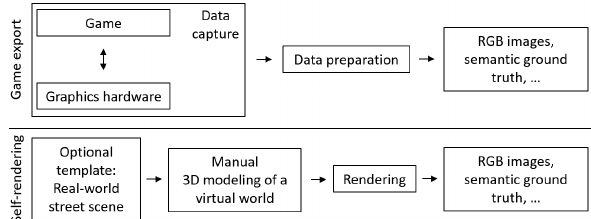
Figure 3. Approaches used to produce the synthetic data in datasets in our comparison: Top: Synthetic RGB images and buffer data are exported from video games playing on streets of a virtual world, buffer data is processed to get the semantic ground truth images. Bottom: A virtual world with streets is created by 3D modeling artificially, the synthetic RGB images and semantic ground truth images are rendered from the models.